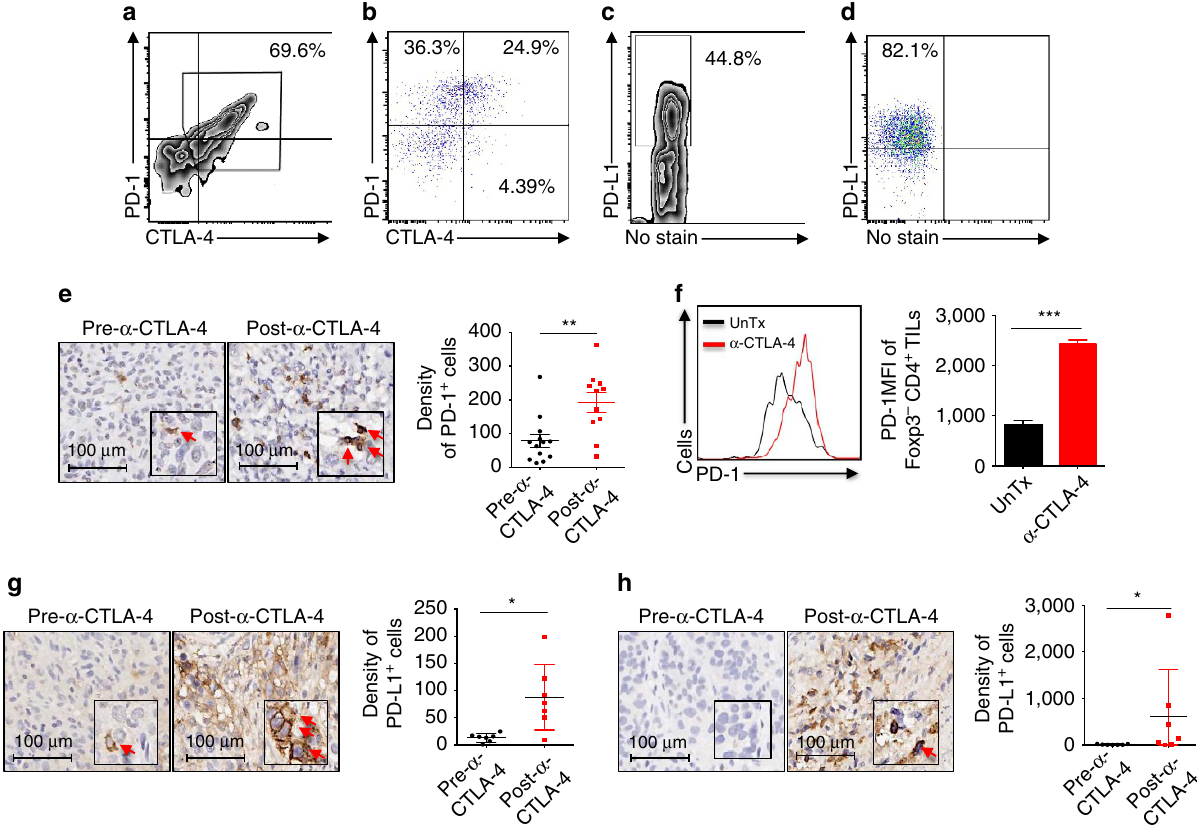
Figure 1 | a -CTLA-4 upregulates the PD-1/PD-L1 inhibitory pathway in human and murine bladder tumours. ( a , b ) Surface expression of CTLA-4 and PD-1 in Foxp3 - CD4 þ TILs isolated from patients with bladder cancer ( a ) and from murine MB49 bladder tumours ( b ). ( c , d ) PD-L1 expression on human ( c ) and mouse ( d ) bladder tumour cells analyzed by flow cytometry. ( e ) PD-1 expression on immune cells from pre- and post- a -CTLA-4-treated human bladder tumour by IHC. Representative IHC photos (arrows indicate positively-stained cells) and pooled results from all the patients are shown. ( f ) PD-1 expression on Foxp3 - CD4 þ TILs isolated from MB49 tumour-bearing mice treated with ( a -CTLA-4) or without a -CTLA-4 (UnTx) were analyzed by flow cytometry. Histograms of PD-1 (left) and pooled results (right) from five mice in one representative experiment are shown. ( g , h ) PD-L1 expression on tumour cells ( g ) and immune cells (H) of pre- and post- a -CTLA-4-treated human bladder samples by IHC. Representative IHC photos (arrows indicate positively-stained cells) and pooled results from all the matched cases are shown. Data in scatter plots and the bar graph are means ± s.e.m. Representative results ( b , d , and f ) from three independent experiments are shown. * P o 0.05; ** P o 0.01; *** P o 0.001 by two-tailed unpaired Student’s t